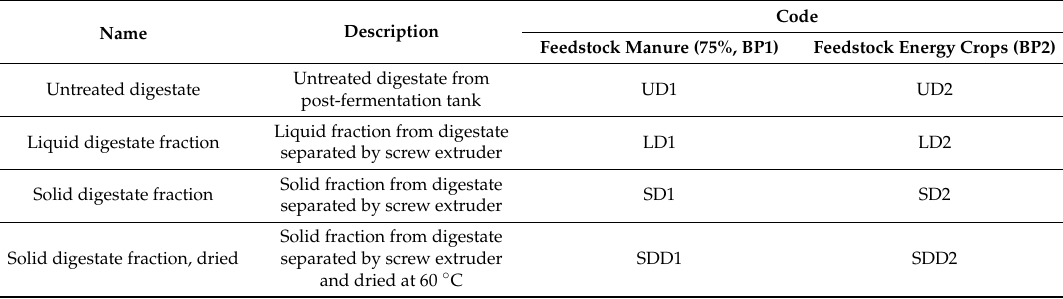
Table 1. Description and code of digestate